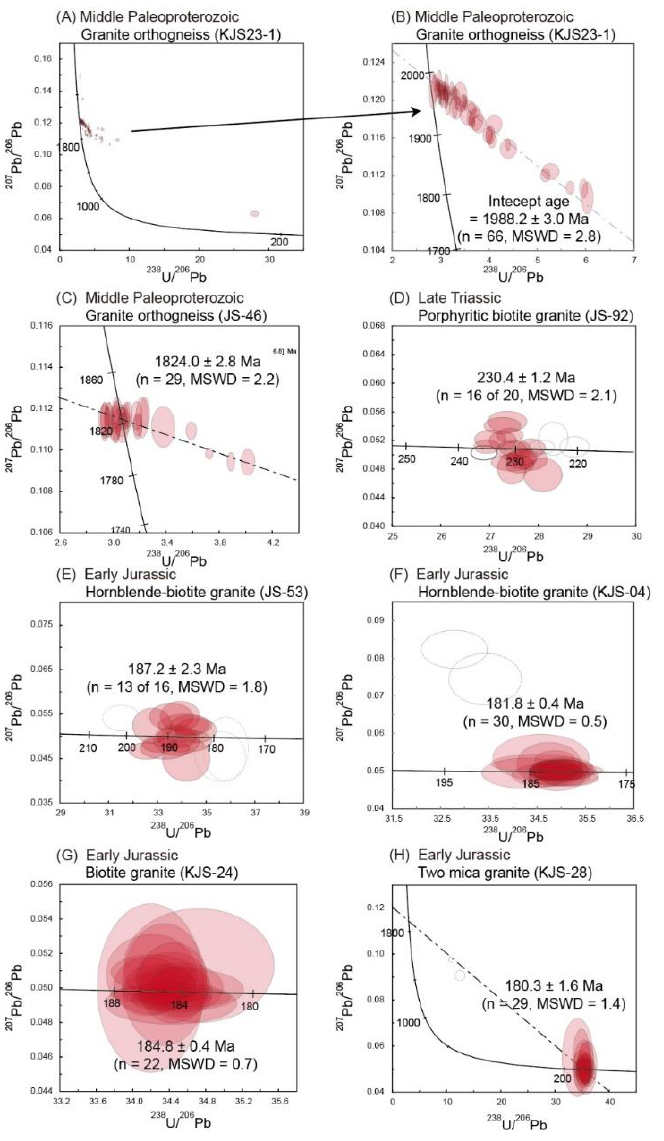
Figure 5. Tera–Wasserburg concordia plots of LA-MC-ICPMS and SHRIMP U-Pb isotopic analyses of zircons from the Middle Paleoproterozoic granite orthogneisses, Late Triassic and Early Jurassic granites in the Jangsun-gun area. KJS-23-1 Middle Paleoproterozoic granite orthogneiss ( A , B ), JS-46 Middle Paleoproterozoic granite orthogneiss ( C ), JS-92 Late Triassic biotite granite ( D ), JS-53 and KJS-04 Early Jurassic hornblende-biotite granites ( E , F ), KJS-24 Early Jurassic biotite granite ( G ), and KJS-28 Early Jurassic two-mica granite ( H ).